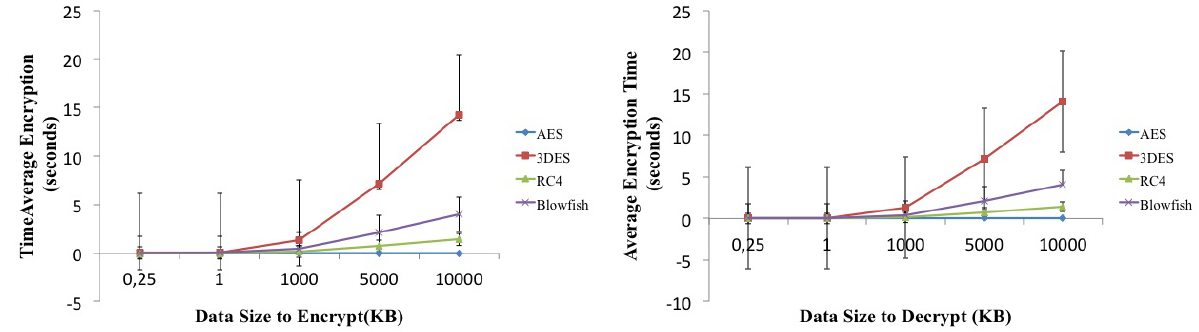
Figure 5. Comparison of encryption and decryption of symmetric algorithms (AES, 3DES, RC4, and